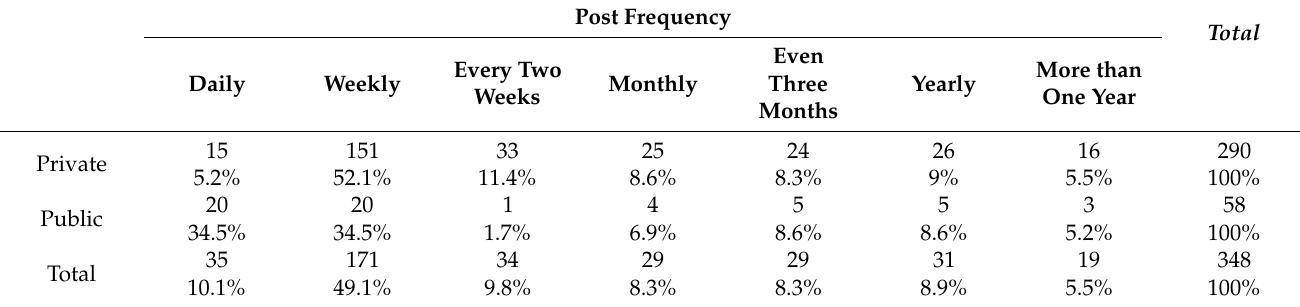
Table 3. Use of social media every day or on a weekly basis by public facilities.